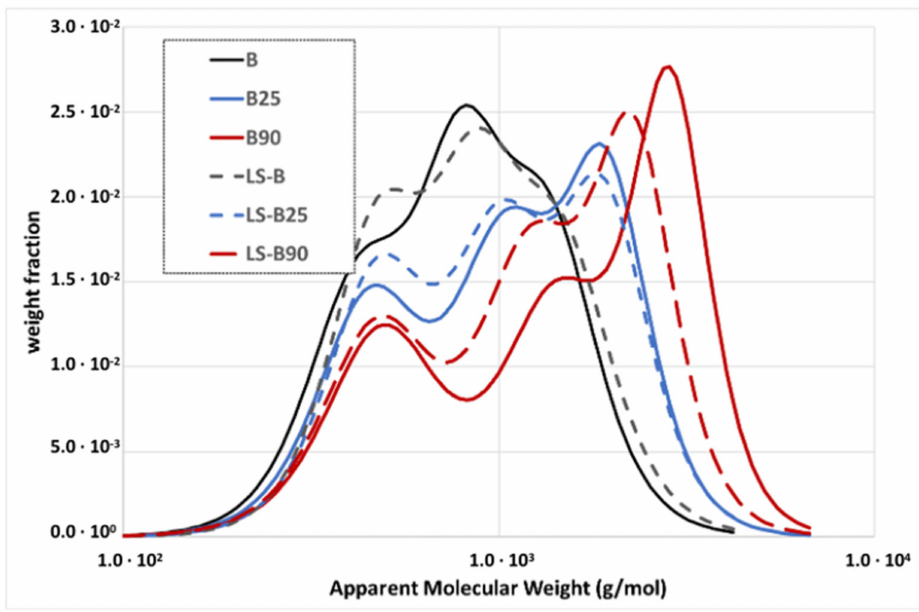
Figure 8. AMWD comparison of the unaged, 25, and 90 h PAV aged samples.